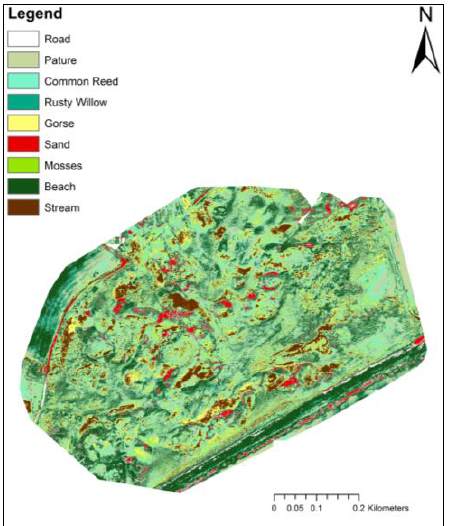
Figure 8. Vegetation mapping of Buckroney dune complex using third classification strategy (Red + Green + Blue + Red edge + NIR).